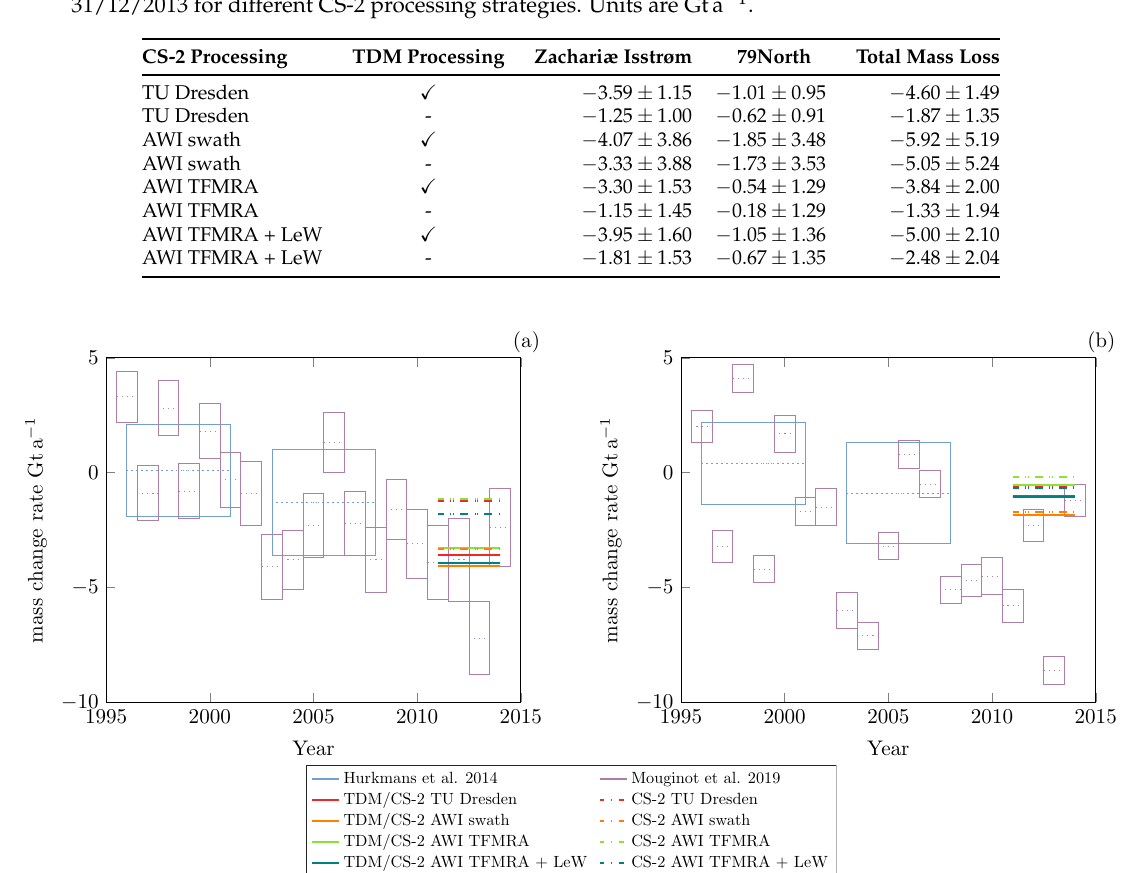
Figure 7. Mass loss from the volumetric approach of Hurkmans et al. [10] and the mass-budget method by Mouginot et al. [14] together with results from different combinations of surface elevation change measurements as in Table 6. The mass losses are partitioned to the individual glacier basins of ( a ) Zachariæ Isstrøm (ZI) and ( b ) Nioghalvfjerdsfjorden (79North). For better visibility, the mass losses are plotted without uncertainty